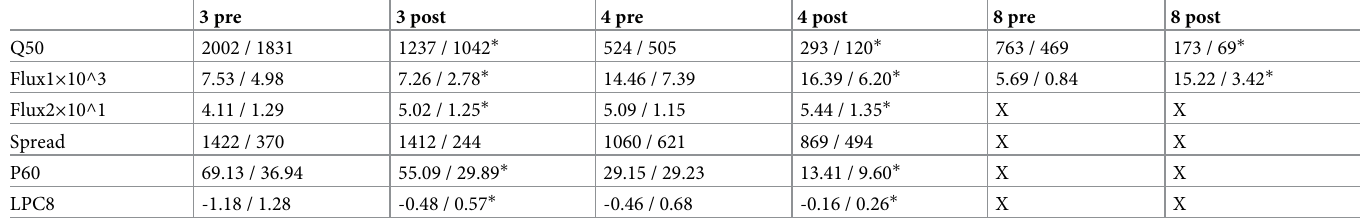
Table 4. Average values / standard deviations of acoustic samples recorded before and within 2 weeks after COVR implant surgery for P < 0.05 for all parameters in all pigs except Spread which was not significant after